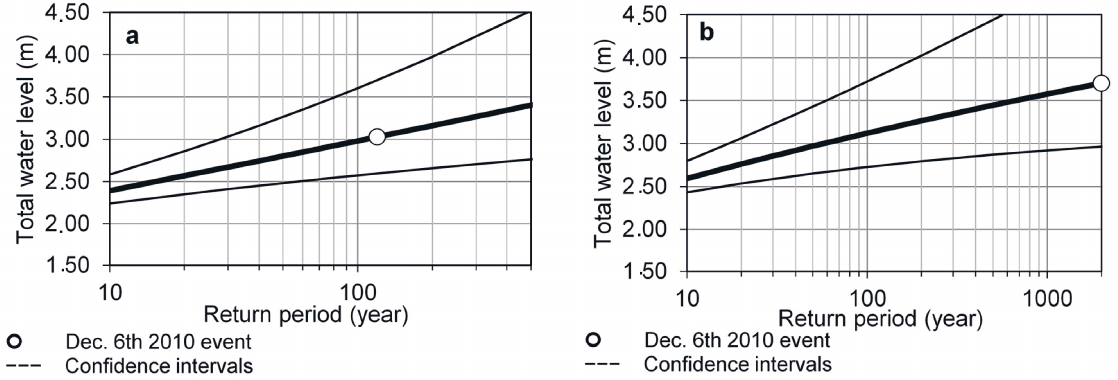
Figure 12. Estimated total water levels return periods at Belledune tide station according to the peak over threshold method including ( a ) wave runup for the natural beach on the eastern part of the study site and ( b ) significant wave height for the defended area on the west zone. Table 3. Estimated extreme total sea levels for ( a ) (high water tide + sea-level rise + storm surge + wave runup) and ( b ) (high water tide + sea-level rise + storm surge + significant wave height) for different return periods for years 2005, 2010, 2020 and 2030 at Belledune tide